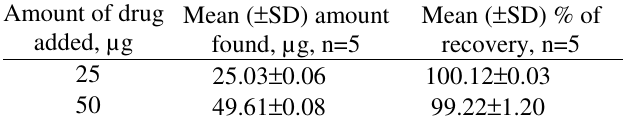
Table 2. Recovery of adefovir dipivoxil using proposed RP-HPLC method.